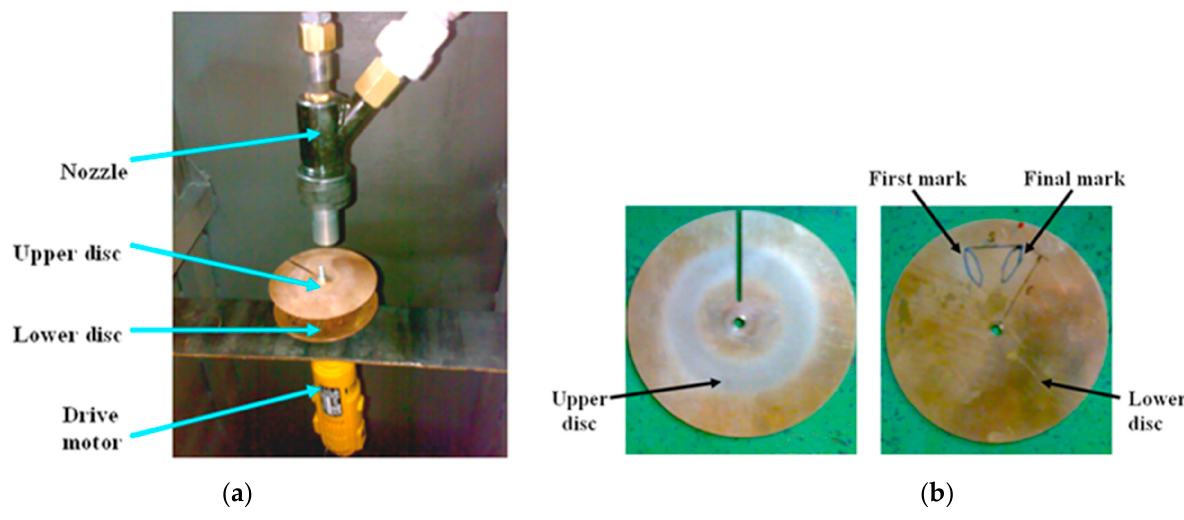
Figure 7. Double-disc method: ( a ) position of motor, nozzle, and discs, and ( b ) erosion marks on discs.